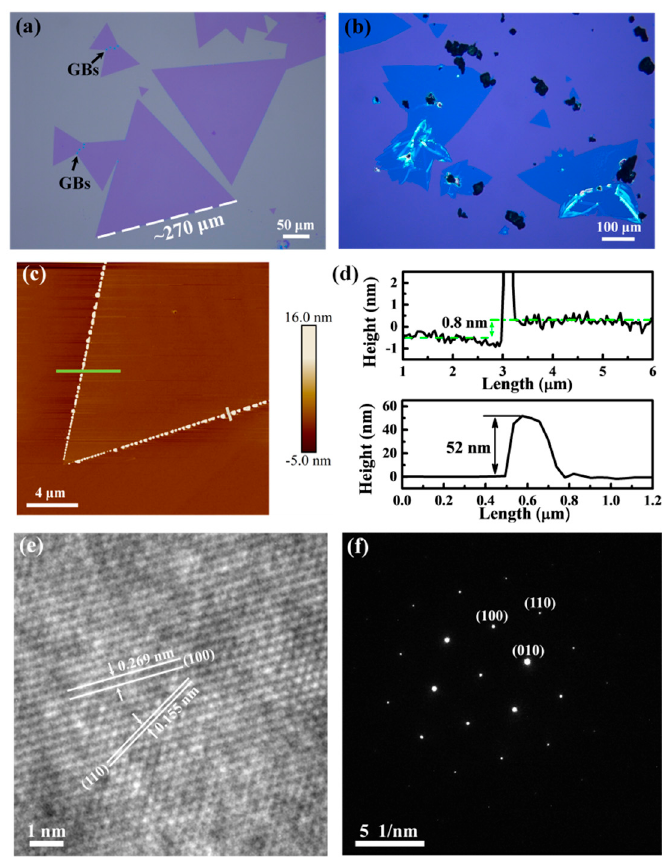
Figure 2. Representative optical images of the as-grown WS 2 flakes on the covering ( a ) and bottom ( b ) SiO 2 /Si substrates, respectively. AFM image ( c ) and its corresponding height profiles ( d ) of an equilateral triangular WS 2 flake on SiO 2 /Si substrate. High-resolution TEM image ( e ) and its corresponding SAED pattern ( f ) of the as-grown triangular WS 2 transferred on a holy carbon-coated copper TEM grid.